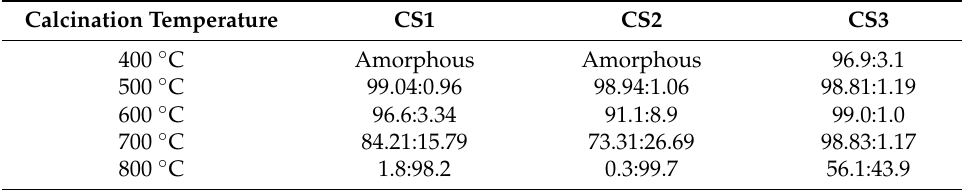
Table 4. Phase composition of hollow titania via calcination temperature.